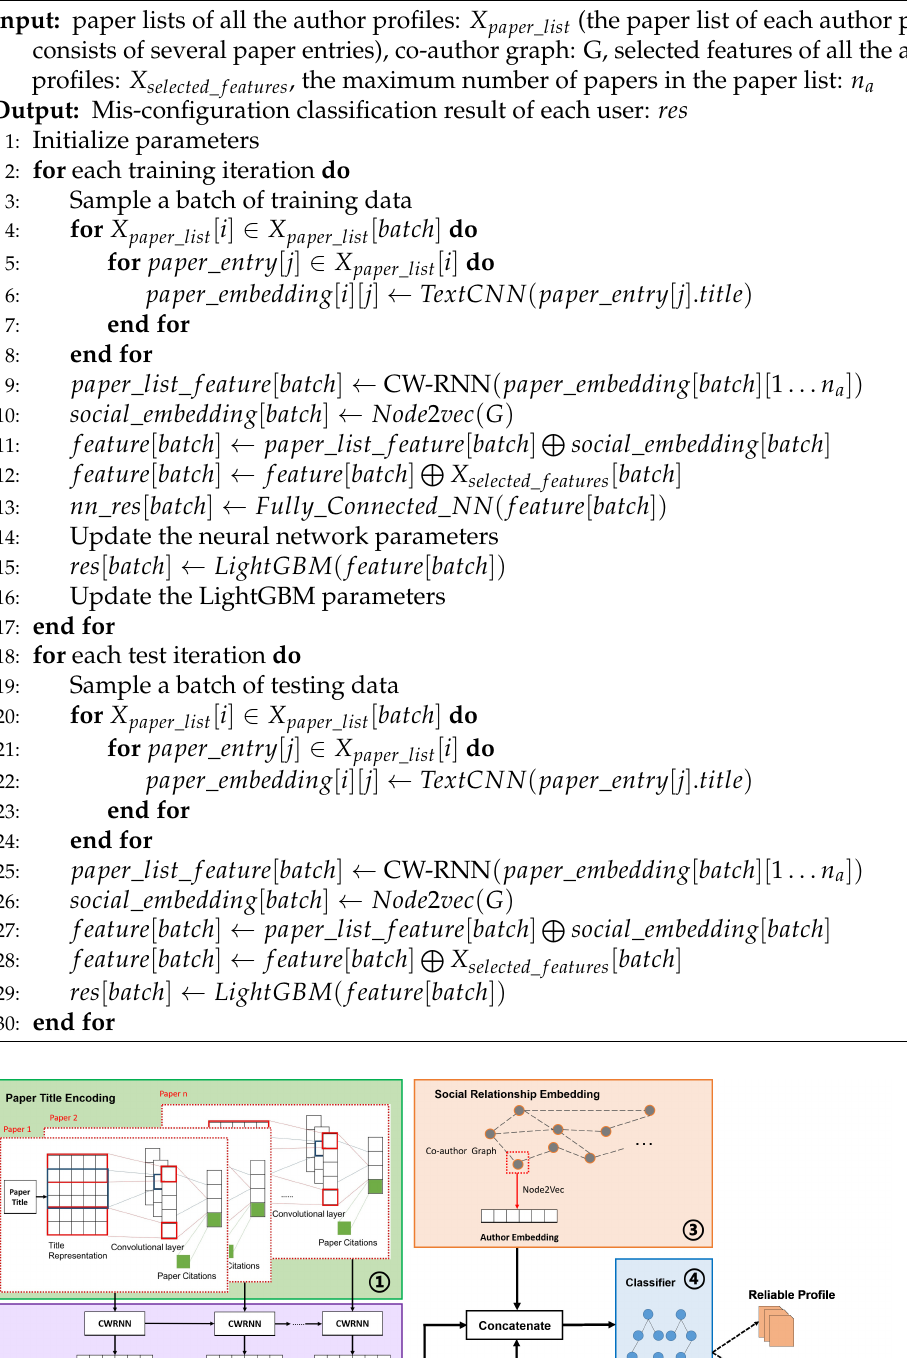
Algorithm 1 The pseudocode of the mis-configuration detection model.